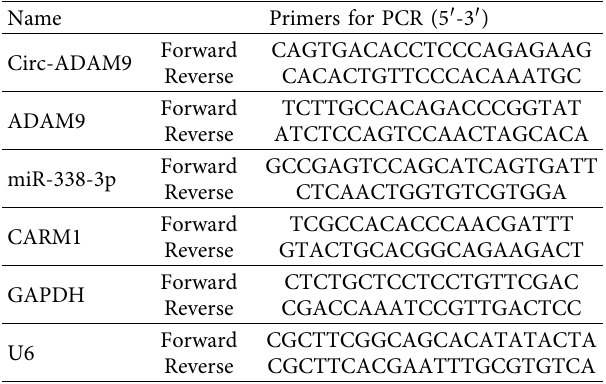
Table 2: Primer sequences used for qRT-PCR.